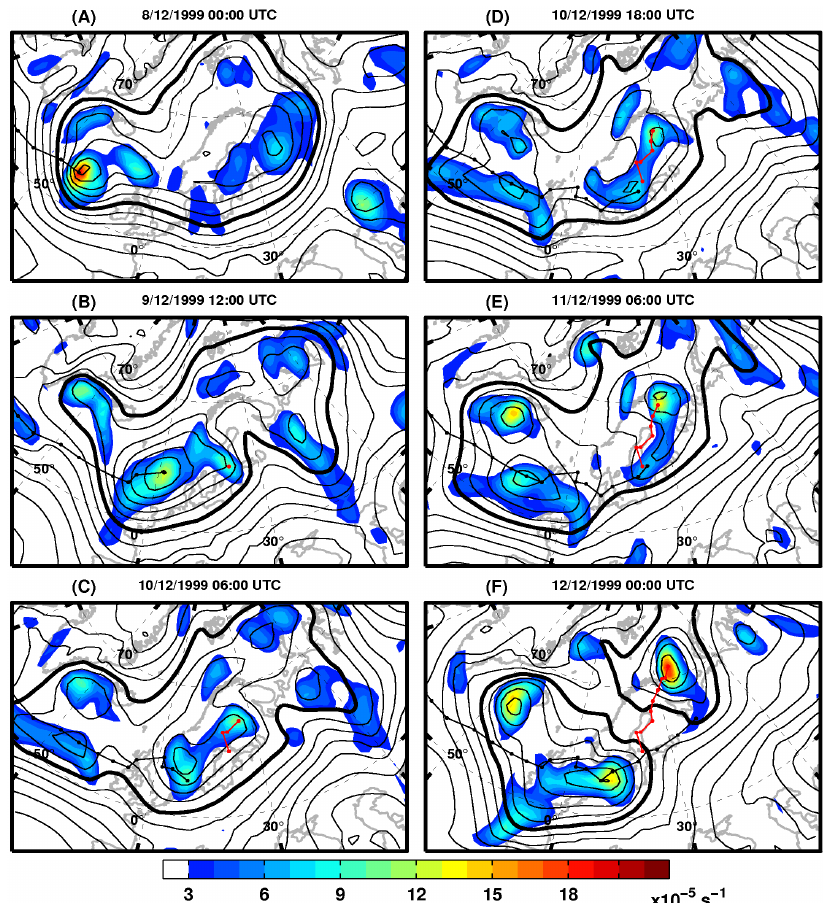
Figure 4. Relative vorticity smoothed by a 3 × 3 spatial filter (color bar); sea level pressure (contours, with a 5hPa interval; thick contour denotes 1000hPa); and tracks (thin lines) of two splitting cyclones for different times during December